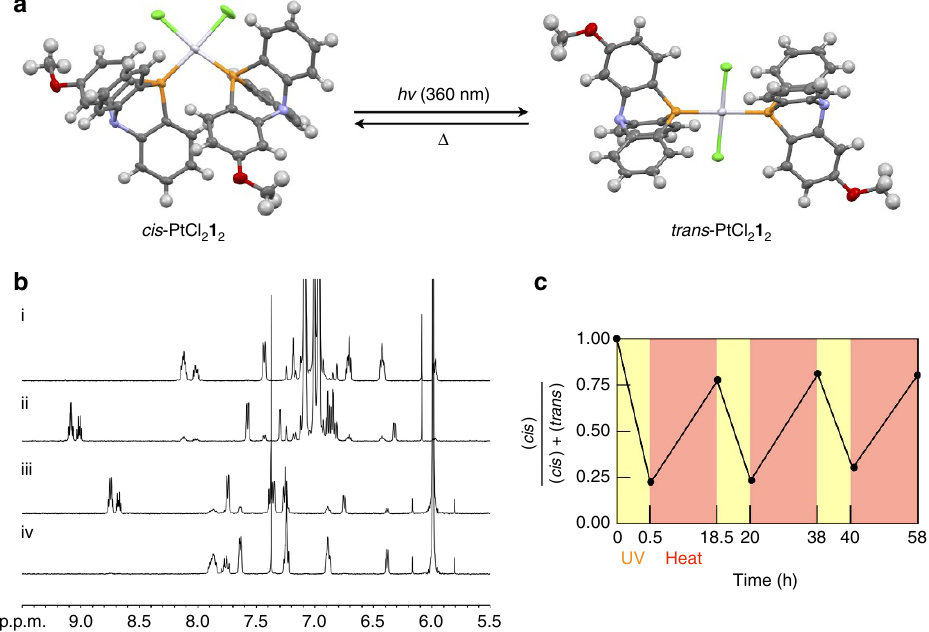
Figure 4 | Photo and thermal switching of molecular gear PtCl 2 1 2 . ( a ) Photo- and thermally induced isomerization between cis - and trans- PtCl 2 1 2 . ( b ) 1 H NMR spectra for photo- and thermally induced isomerization from cis - to trans- PtCl 2 1 2 (500MHz, 300K). (i) A solution of single crystals of cis -PtCl 2 1 2 in toluene- d 8 ( cis / trans ¼ 99:1); (ii) a solution of (i) after photoirradiation at 360nm (after 30min, cis / trans ¼ 15:85); (iii) a solution of single crystals of trans -PtCl 2 1 2 in TCE- d 2 (after 5min, cis / trans ¼ 12:88); (iv) a solution of (iii) after 10h at room temperature ( cis / trans ¼ 2:98). ( c ) Reversible switching of the molecular gearing system, PtCl 2 1 2 , in TCE- d 2 /toluene- d 8 ¼ 1:1 (vv (cid:2) 1